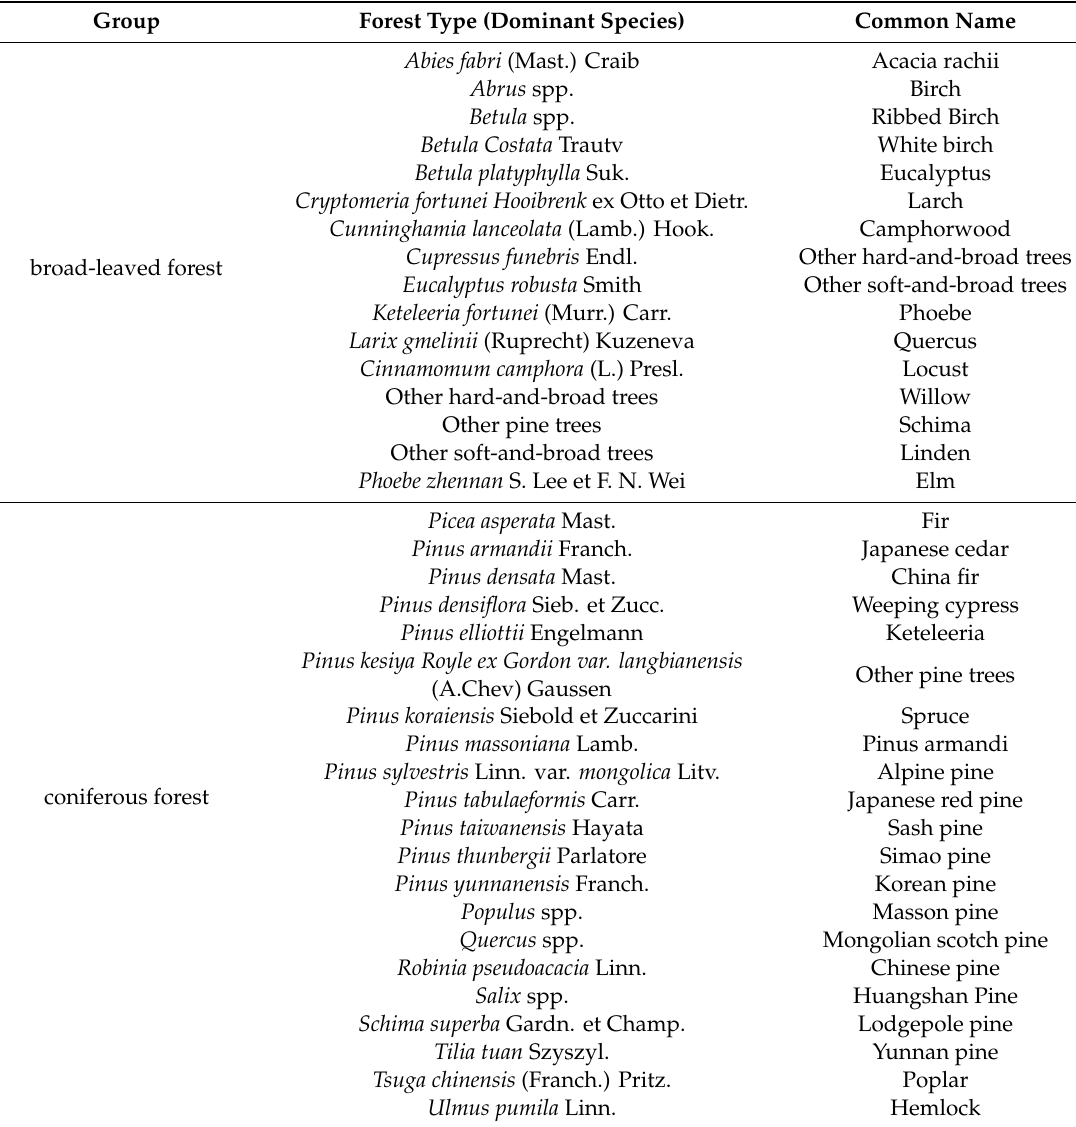
Table A2. Groups and common names corresponding to forest types (dominant species).